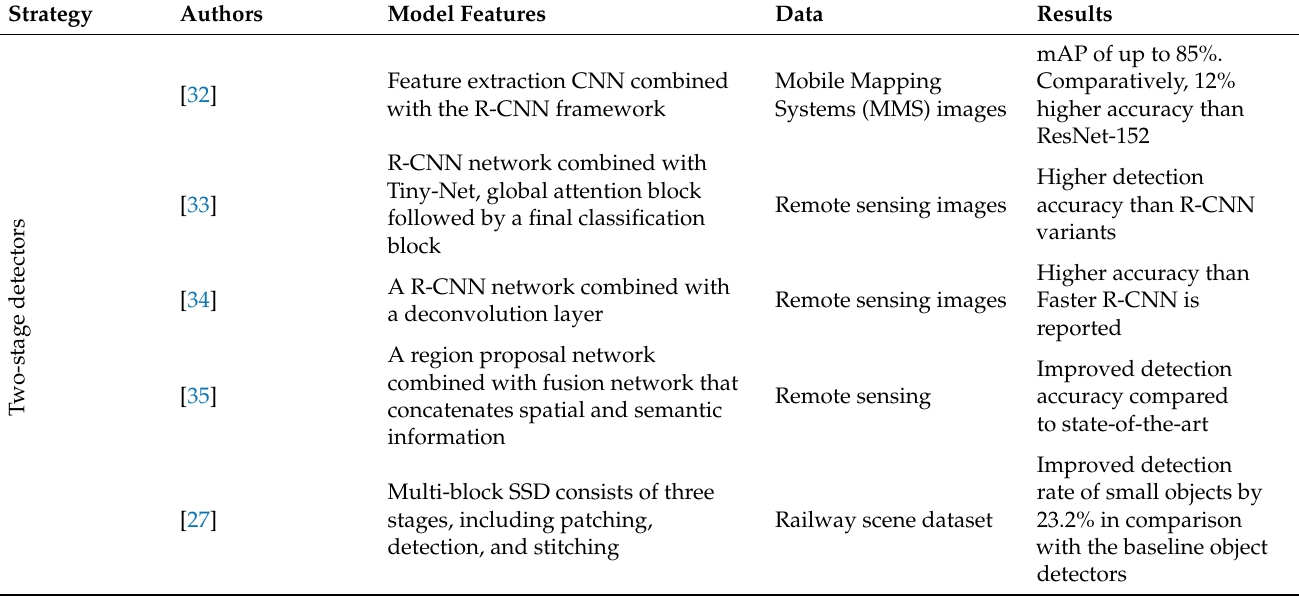
Table 1. A summary of selected works on CNN-object detection for small objects in